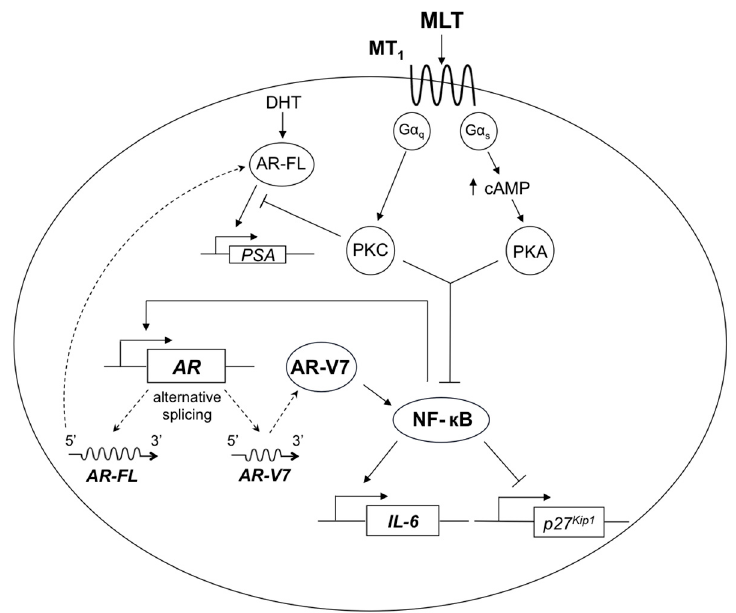
Figure 8. Schematic diagram showing the signaling pathways involved in melatonin receptor-mediated growth inhibition of prostate cancer cells. → denotes activation (may involve multi-steps); (cid:97) denotes inhibition (may involve multi-steps). AR-FL and AR-V7 are full-length and truncated forms of AR, respectively, generated by alternative splicing of AR precursor mRNAs. Dotted line denotes transcription or translation. Abbreviations: MLT, melatonin; PKC, protein kinase C; PKA, protein kinase A; NF- κ B, nuclear factor-kappa B; DHT, dihydrotestosterone; AR, androgen receptor; AR-FL, full-length androgen receptor; AR-V7, androgen receptor splice variant-7; IL-6, interleukin-6; PSA, prostate-specific antigen.